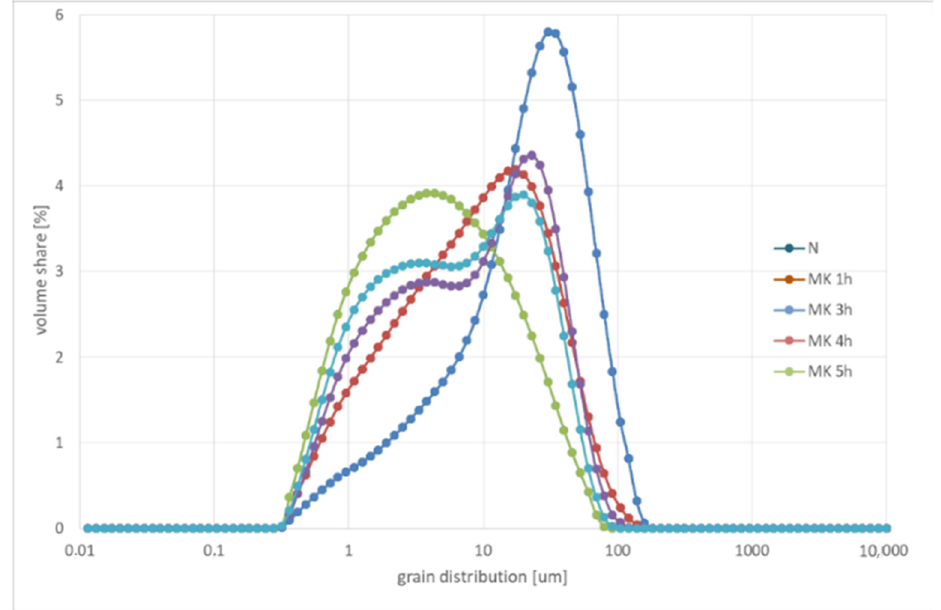
Figure 3. Grain distribution of samples in relation to grinding time. Table 3. Grains’ characteristics of the samples analyzed by laser diffraction.